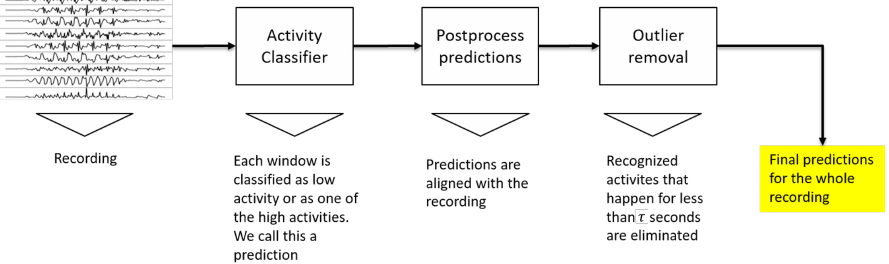
Figure 17. Complete sliding-window evaluation